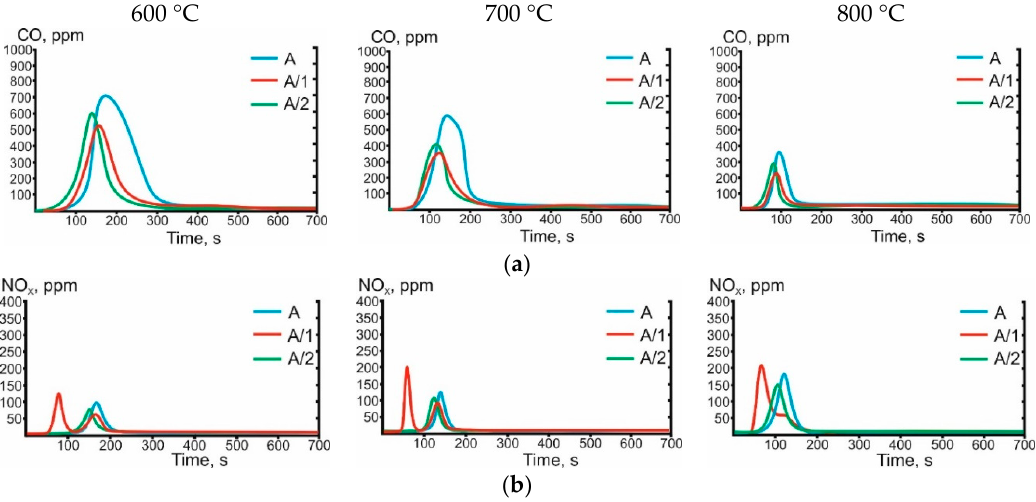
Figure 7. The concentration profiles for the gaseous products formation during the combustion of the studied anthracite samples at different temperatures of heating medium: ( a ) СО ; ( b ) NO x .